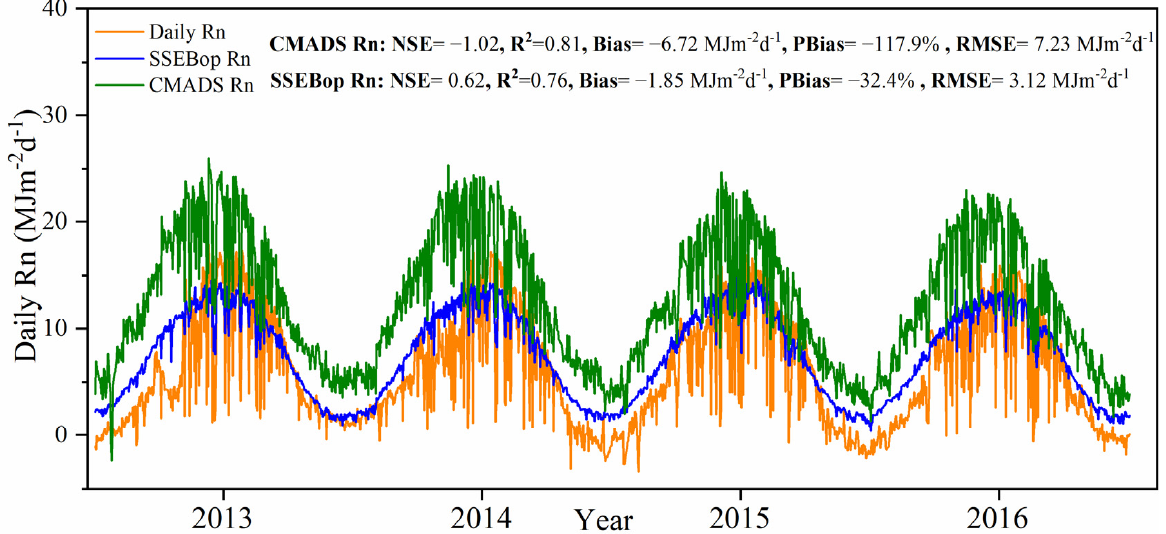
Figure 2. Comparisons of daily net radiation estimated from different methods with AWS measured ground truth.